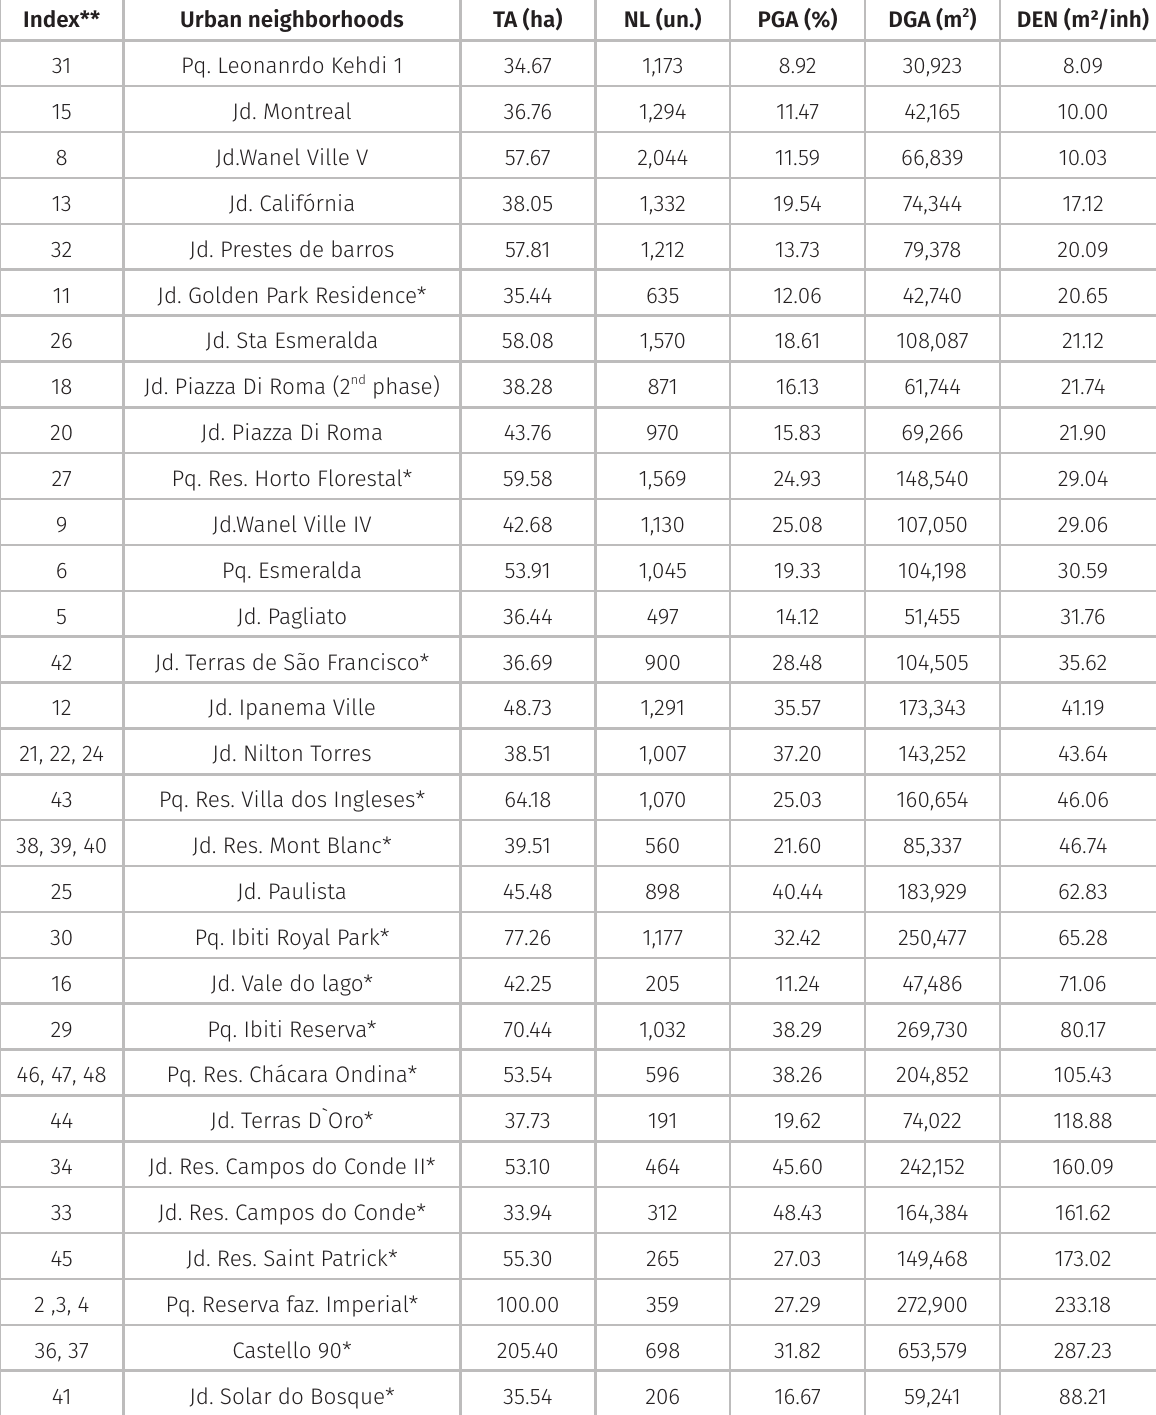
Table I. Urban neighbourhoods selected for the sample